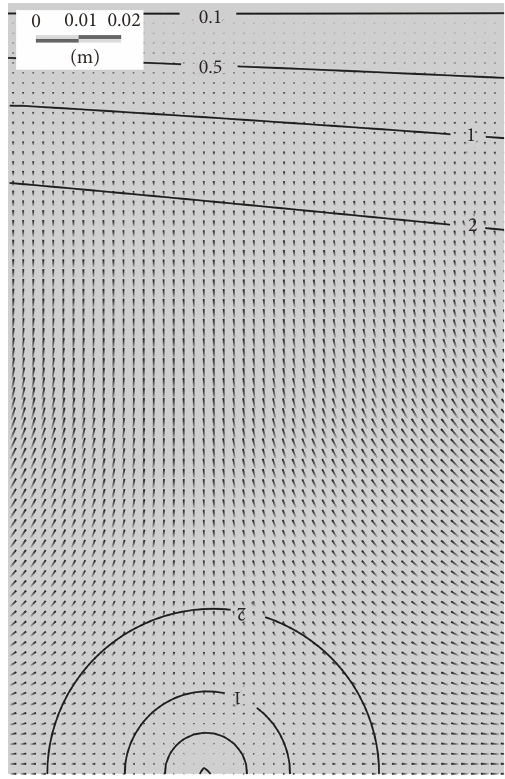
Figure 7: Excerpt view of Figure 6, at t = 180 s . Additional fl ow velocity vectors are shown for each node (small black arrows), next to black Darcy velocity contours of 0.1, 0.5, 1, and 2